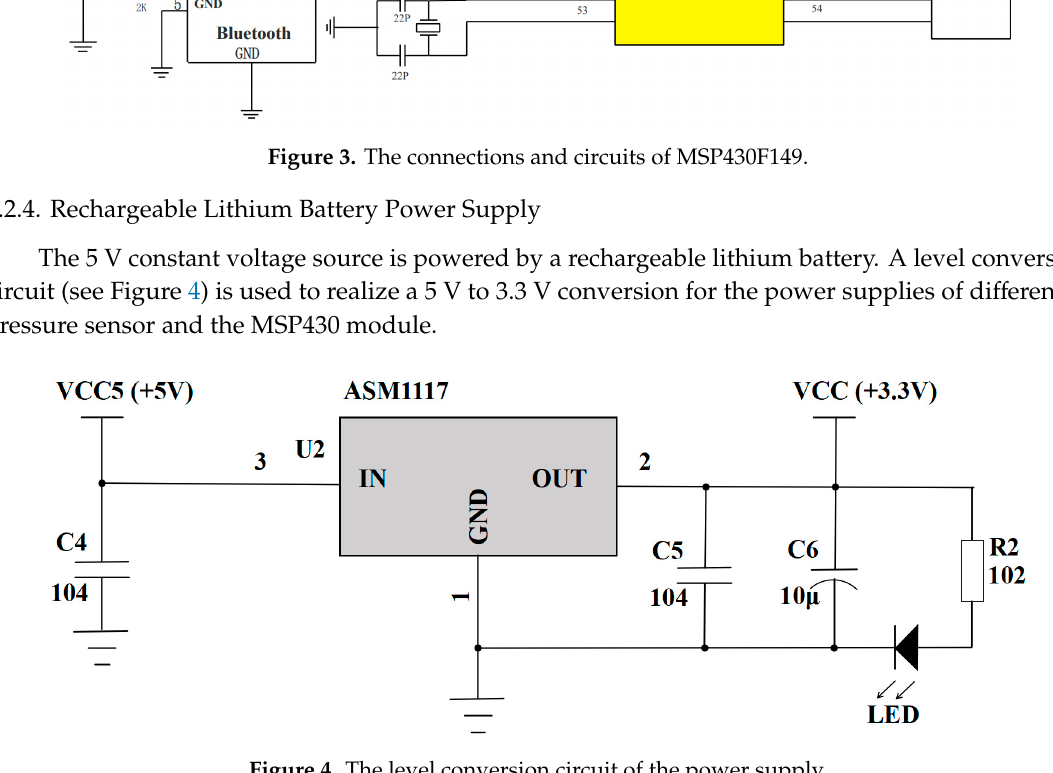
Figure 4. The level conversion circuit of the power supply.